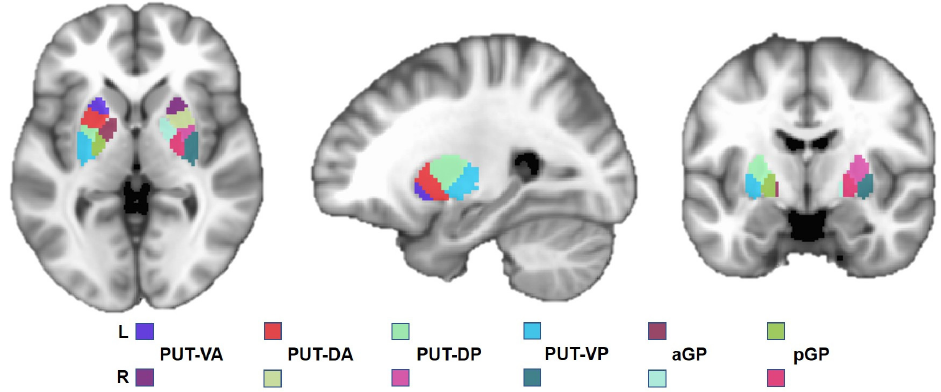
Figure 1. Definition of ROIs. Abbreviations: L, left; R, right; PUT-VA, ventral anterior putamen; PUT-DA, dorsal anterior putamen; PUT-DP, dorsal posterior putamen; PUT-VP, ventroposterior putamen; aGp, anterior globus pallidus; pGP, posterior globus pallidus.